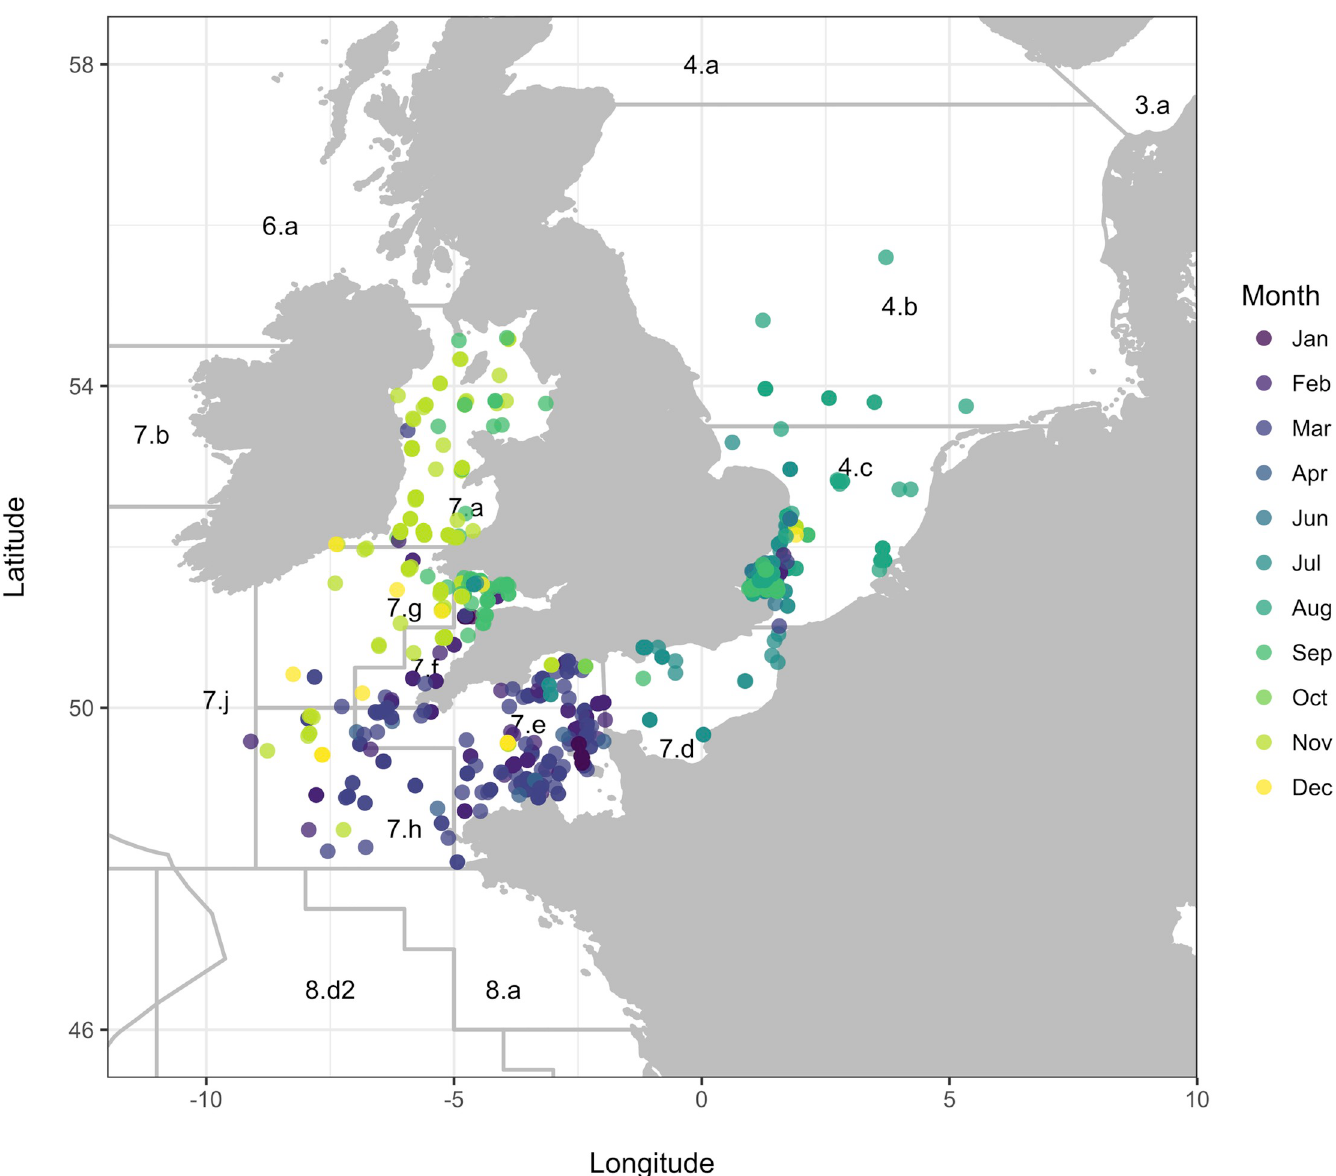
Fig 1. Release locations of M . asterias . Release locations of M . asterias tagged with mark-recapture tags (n = 1390). Points are coloured by month of release. ICES Divisions are labelled and correspond to the following areas: northern North Sea (4.a), central North Sea (4.b), Skagerrak (3.a), southern North Sea (4.c), eastern English Channel (7.d), western English Channel (7.e), Celtic Sea (7.f-h and 7.j), Irish Sea (7.a), west of Scotland (6.a), west of Ireland (7.b) and northern Bay of Biscay (8.a and 8. d2).